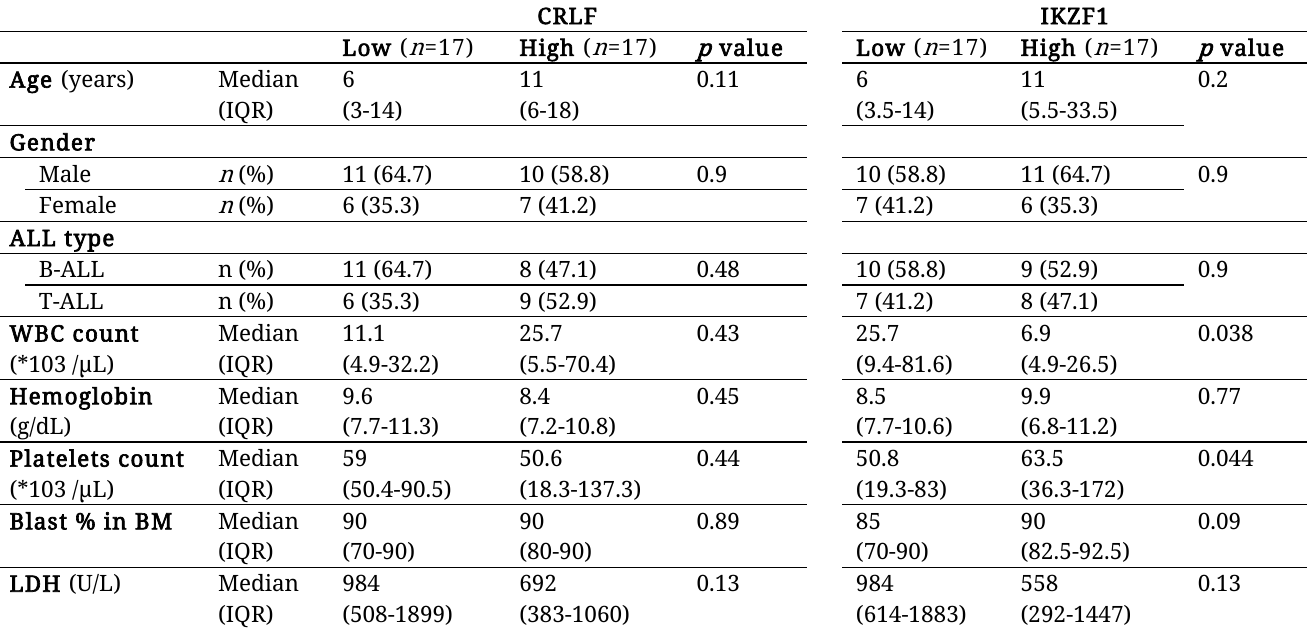
Table 2: Correlation between patients’ characteristics and the level of expression of CRLF2 and IKZF1 among acute lymphoblastic leukemia